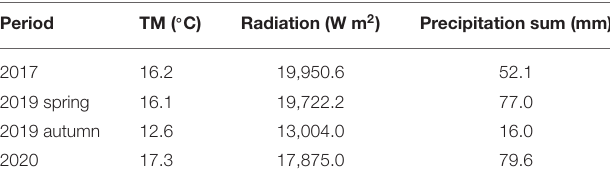
TABLE 1 | Weather conditions (TM: mean daily temperature ( ◦ C) and precipitation sum (mm) during the four investigated periods recorded by the